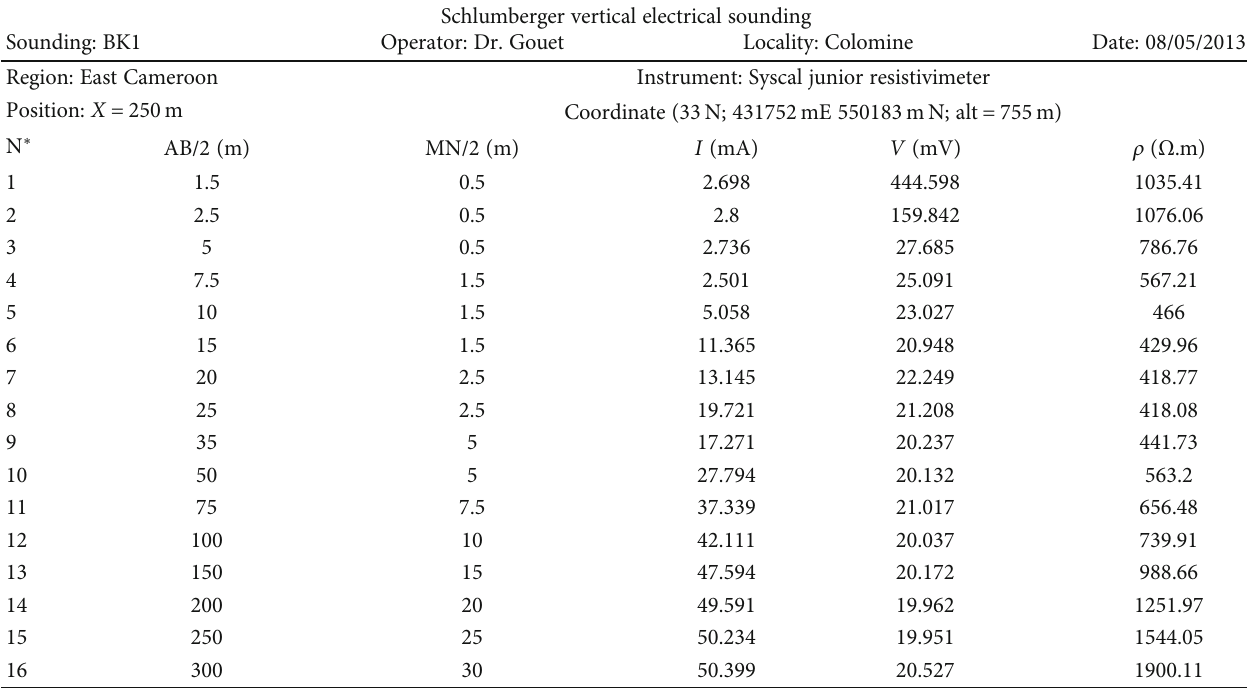
Table 1: Example of the VES